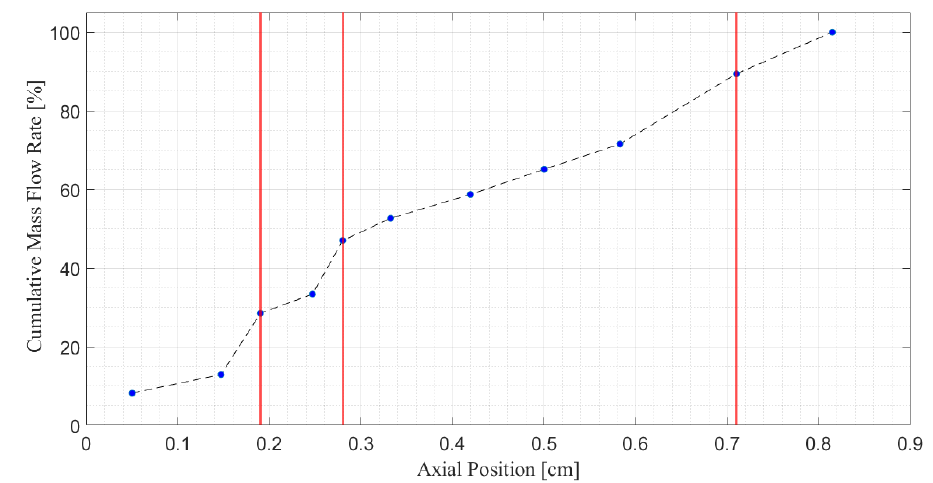
Figure 8. Cumulative mass-flow rate as a function of the axial position in the basket. As it was recalled in Section 3, the flow split amongst the air holes was part of the problem solution. As shown by the figure, this choice appears as essential for a reliable estimation of the flow patterns inside the basket, as well as of the convective heat transfer toward the basket shell. In fact, the mass-flow rate of the cooling slots represents a remark- able fraction of the overall flow. For example, the total primary plus secondary air flow is around 30% of the overall flow rate, and the one of the cooling slots between the secondary and the dilution holes sum up to around 25%. However, it has been shown that the flow split amongst the holes is virtually not affected by the composition of the fuel, under the working conditions considered in this paper. Figures 9 and 10 show the mass-averaged profile of the temperature and the axial velocity, respectively, against the axial position, for the different blends. Both quantities have been normalized to their value in the outlet section of